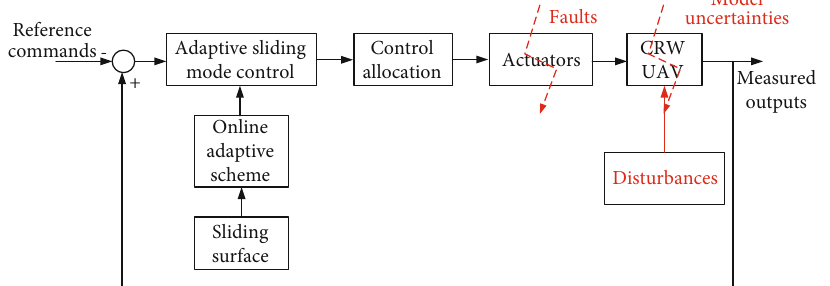
Figure 2: Schematic of the proposed adaptive fault-tolerant control